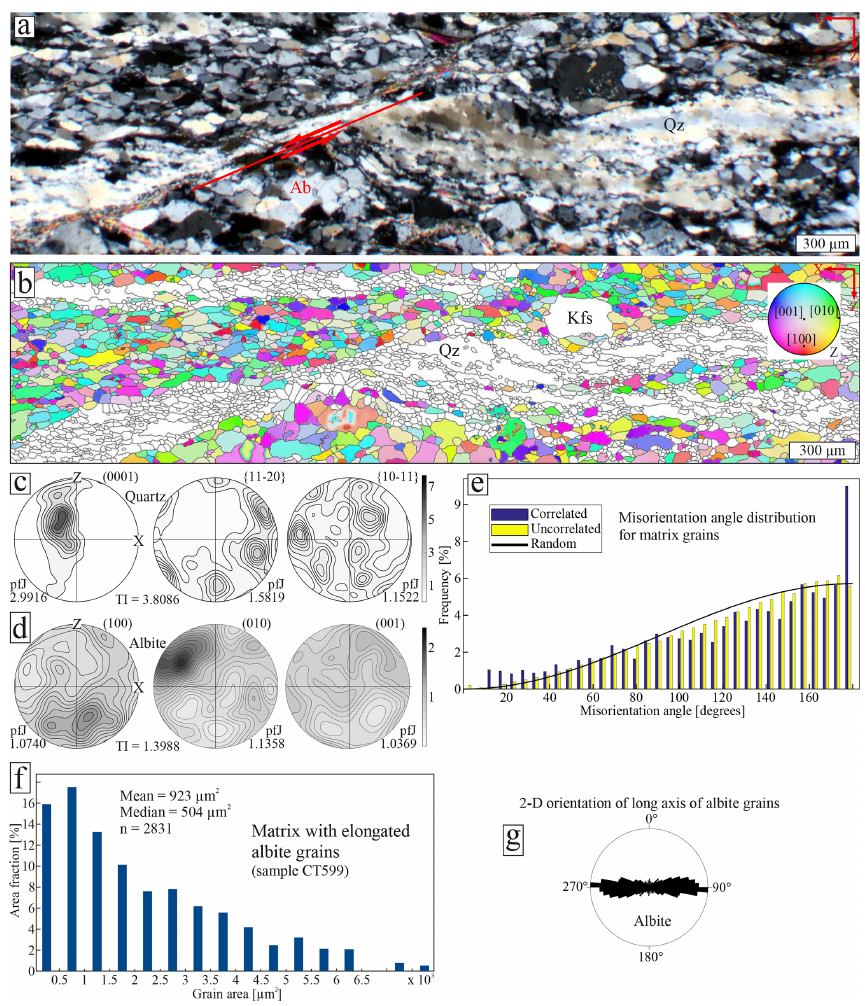
Figure 12. (a) Photomicrograph of the type B matrix with coarse monophase albite and fine-grained quartz layers in sample CT599. Quartz and albite layers are offset at the shear band marked in red. (b) EBSD map of the area from panel (a) with an inverse pole figure (IPF) colour code ( z axis). Only albite is coloured after the IPF colour code. (c) Pole figures for albite grains from panel (b) . (d) Pole figures for quartz grains from panel (b) . (e) Misorientation angle distribution showing an essentially random distribution of neighbouring or random grain pairs. (f) Grain area distribution diagram. (g) Rose diagram of the long axis of albite matrix grains from the area measured by